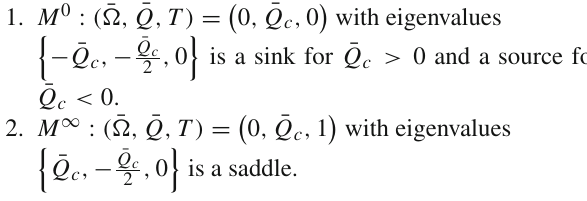
In Fig. 10 the dynamics of the averaged system (145) for γ = 0, 2 and of the averaged system (151) for γ = 1 is 3 ¯ ¯ (cid:8)) Q , D /( 1 + D ), represented in the compact space ( . In Figs. 13, 14, 15, 16, 17, 18, 19, and 20 projections of some solutions of the full system (93) and time-averaged system (127) in the (Σ, D /( 1 + D ), (cid:8) 2 ) and ( Q , D , (cid:8) 2 ) space are presented with their respective projections when D = 0. In Figs. 21, 22, 23, and 24 projections of some solutions of the full system (118) and time-averaged system (145) for γ (cid:7)= 1 and of system (151) for γ = 1 in the ( Q , D /( 1 + D ), (cid:8) 2 ) space are presented with their respective projection when D = 0. Figs. 21 and 25 show how the solutions of the full system (blue lines) follow the track of the solutions of the averaged system (orange lines) for the whole D -range. Fig- ures 22, 23, 24, and 26 are evidence that the main theorem presented in Sect. 4 is fulfilled for the FLRW metric with pos- itive curvature ( k = + 1) only when D is bounded. Precisely, the solutions of the full system (blue lines) follow the track of the solutions of the averaged system (orange lines) for the time interval t D = O ( 1 ) . However, when D becomes infinite ( T → 1) and for γ ≥ 1 we have the following conjecture. full system depart from the solutions of the averaged system